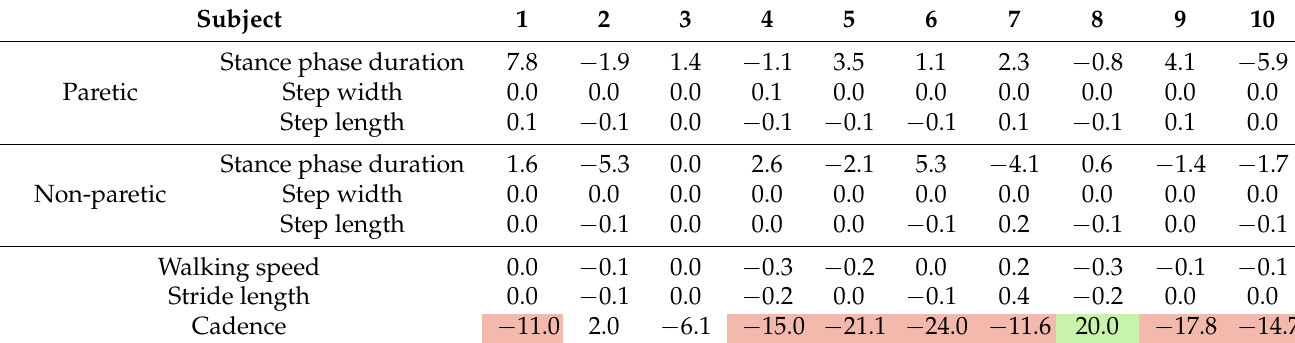
Table 5. Percentage of the variation of the spatial-temporal parameters. The highlighted values indicate a change above 10% for both increases (green) and decreases